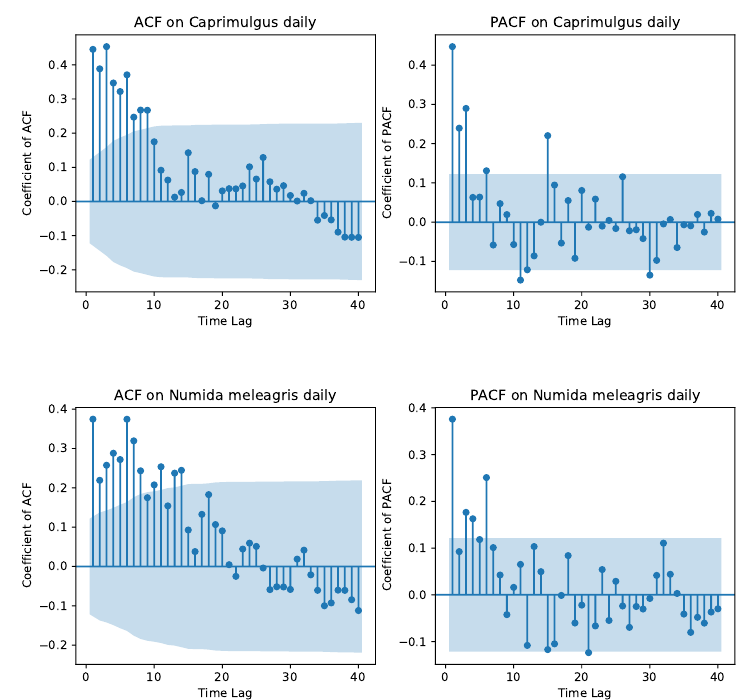
Figure 5. ACF (top-left panel) and PACF (top-right panel) on the Caprimulgus data showing stationar- ity. ACF (bottom-left panel) and PACF (bottom-right panel) on the Numida meleagris data showing stationarity on endogenous variables